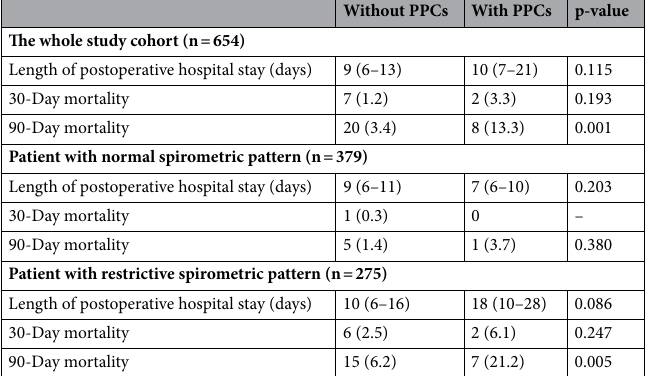
Table 3. Association between postoperative pulmonary complication (PPC) and postoperative clinical courses. Data are presented as median (25th percentile, 75th percentile) or frequency (%).